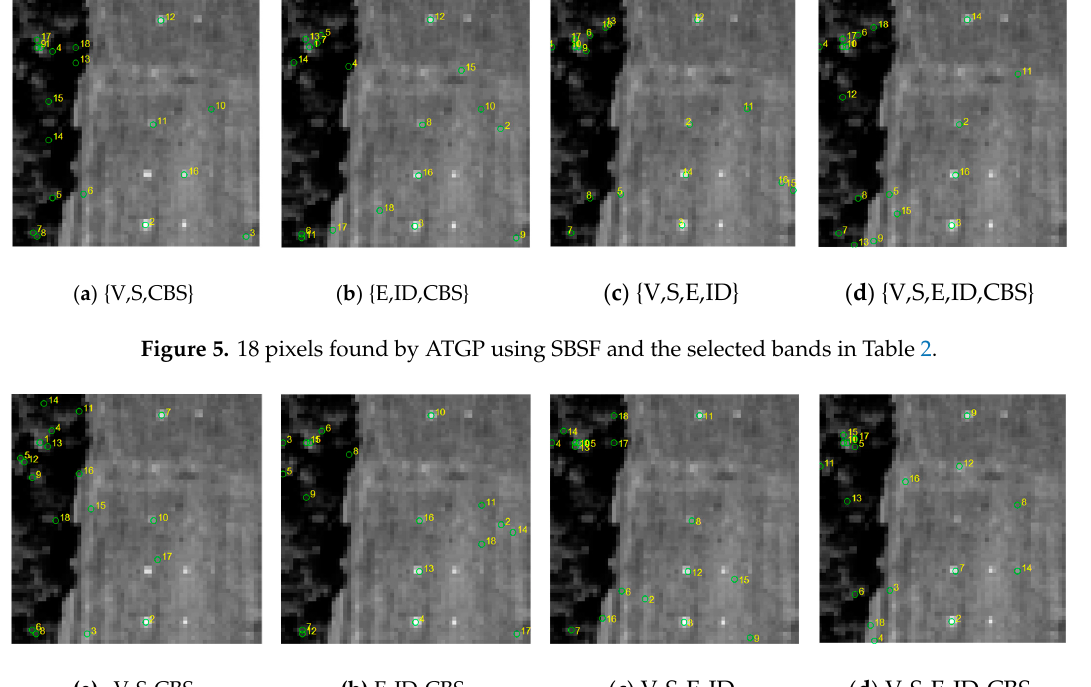
selected bands in Table 1.